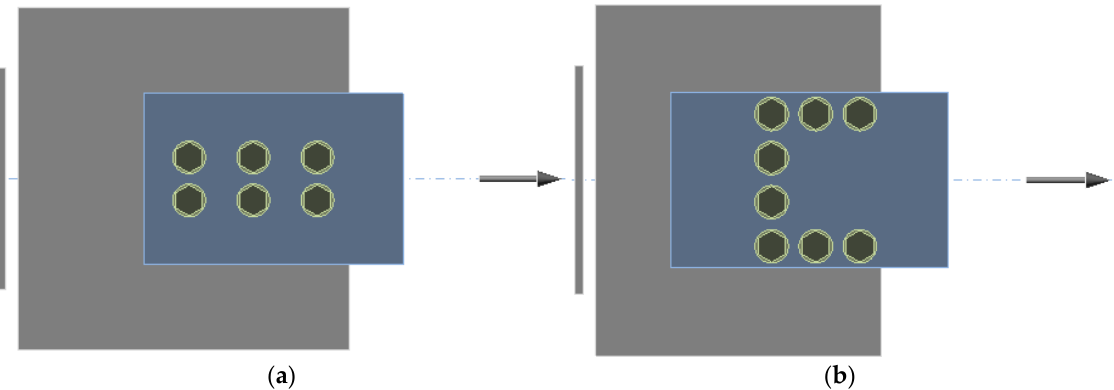
Figure 13. CBFEM model of ( a ) specimen T1 and ( b ) specimen T2.